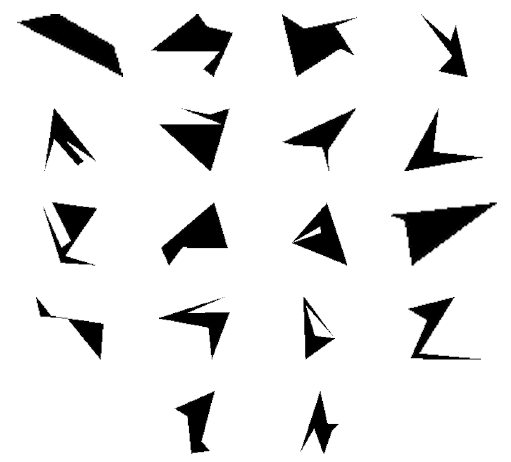
Figure 2. Entire set of shape